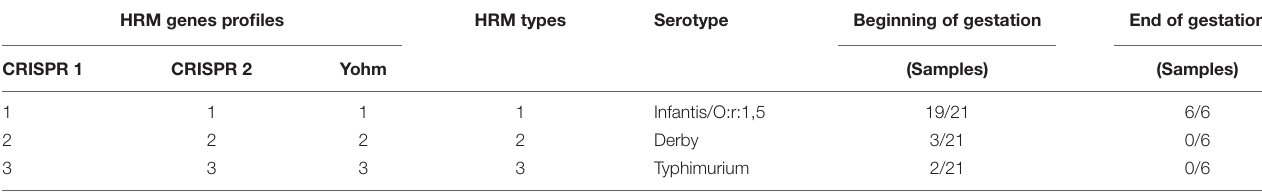
TABLE 3 | Comparison of alpha-diversity indices across sow groups and according to Salmonella shedding status and time of gestation.